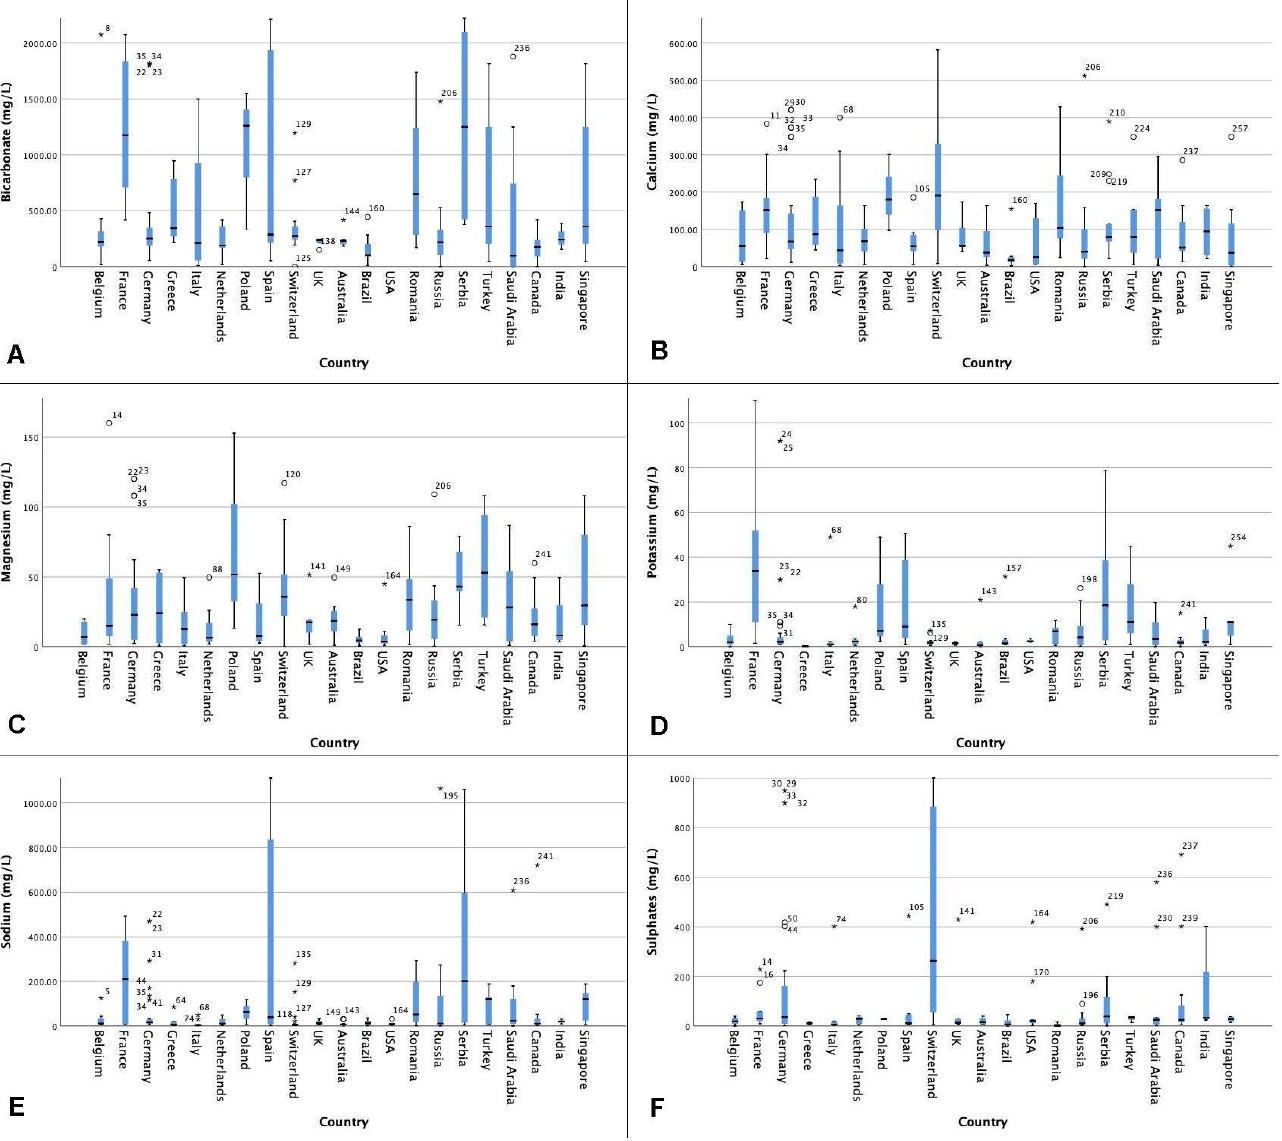
Figure 2. ( A–F ): The mineral composition of bottled sparkling water (mg/L) per mineral by country. ° Outlier. * Extreme value. Overall, for sparkling or carbonated water, bicarbonate levels ranged from 0 mg/L